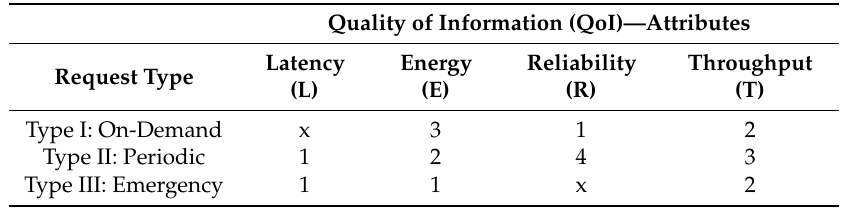
Table 1. Energy and Quality of Information (QoI) attribute priority for different data traffic